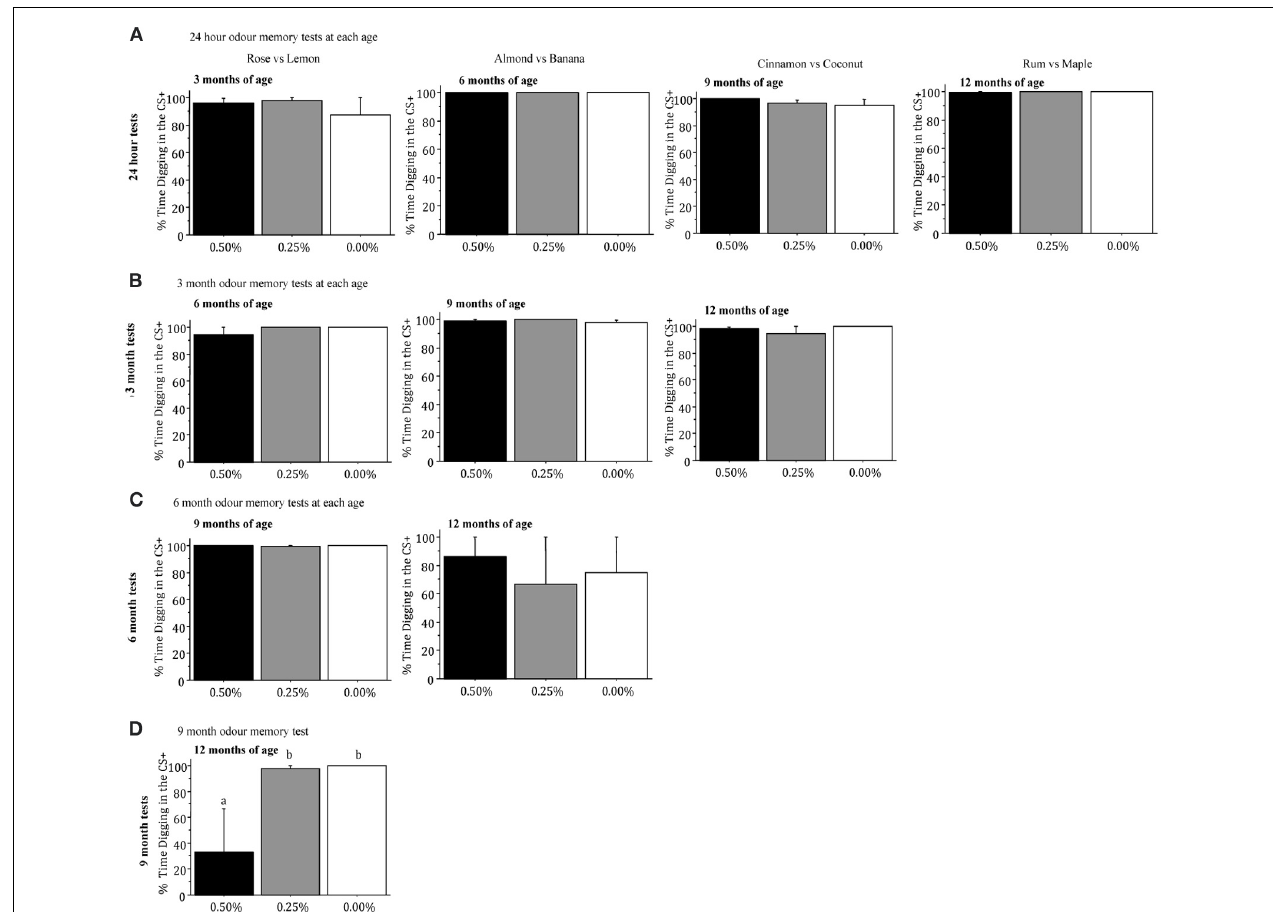
FIGURE 4 | Mean ( ± S.E.M.) percentage of time spent digging in the CS + when mice were tested for memory 24h (A), 3 months (B), 6 months (C), and 9 months (D) after training in the conditioned